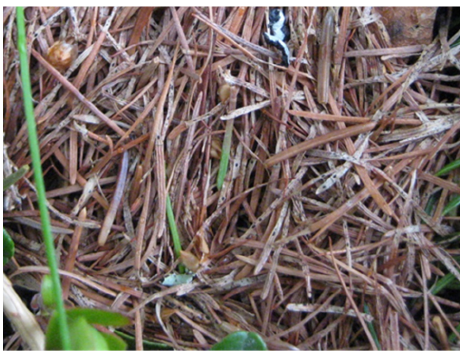
Figure 4. Abundant Lophodermium sp. on previous ‐ year needle litter of Siberian larch in the Kivalo Research Forest, Rovaniemi, 19 June 2015. Some needles are full of fruiting bodies of Mycosphaerella laricina .